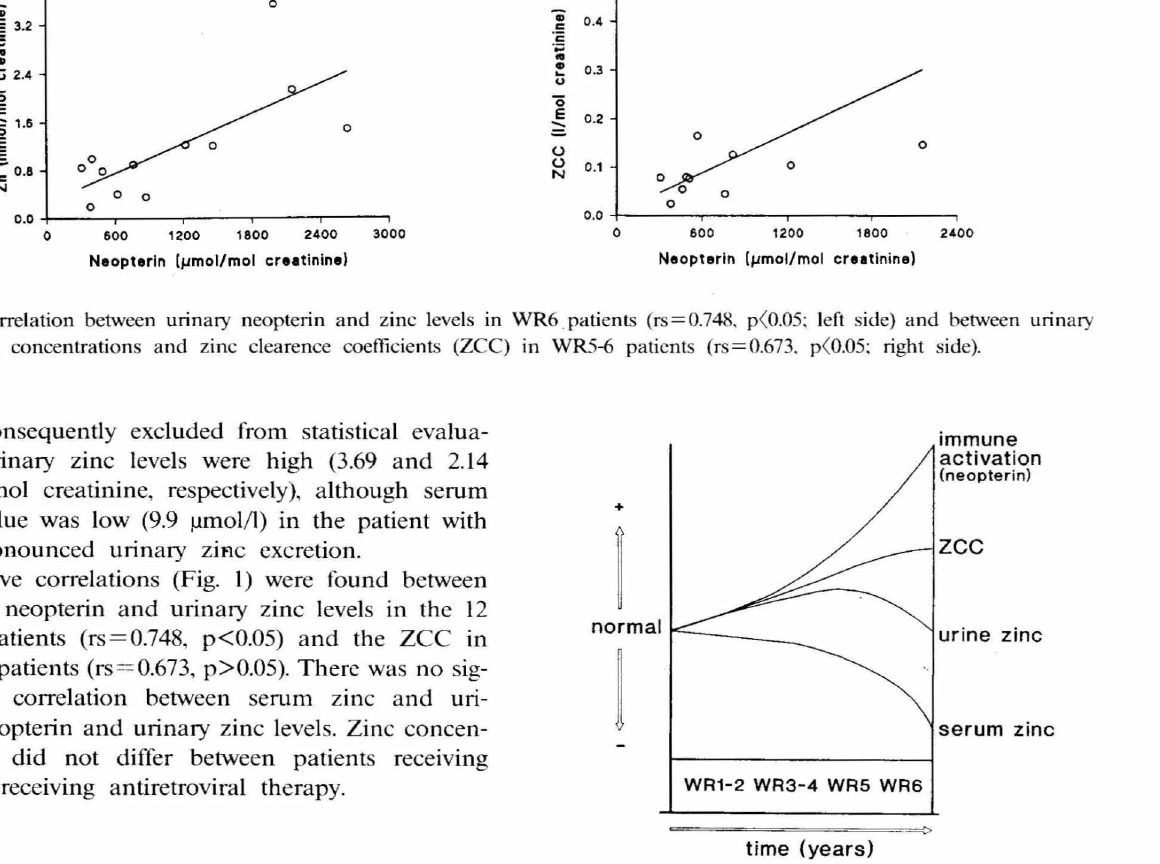
Figure 2. Simplified scheme of zinc metabolic changes toge ther with immune activation in patients with HIV-I infection: Immune activation in patients with HIV-l infection: Immune activation increases throughout the course of disease (indicated by, e.g .. neopterin levels) whereas serum zinc levels decrease. Urinal)' excretion of zinc increases in early stages but starts to decrease in later stages when zinc deficiency becomes ap parent, but zinc c1earence coefficient (ZCC) remains to be